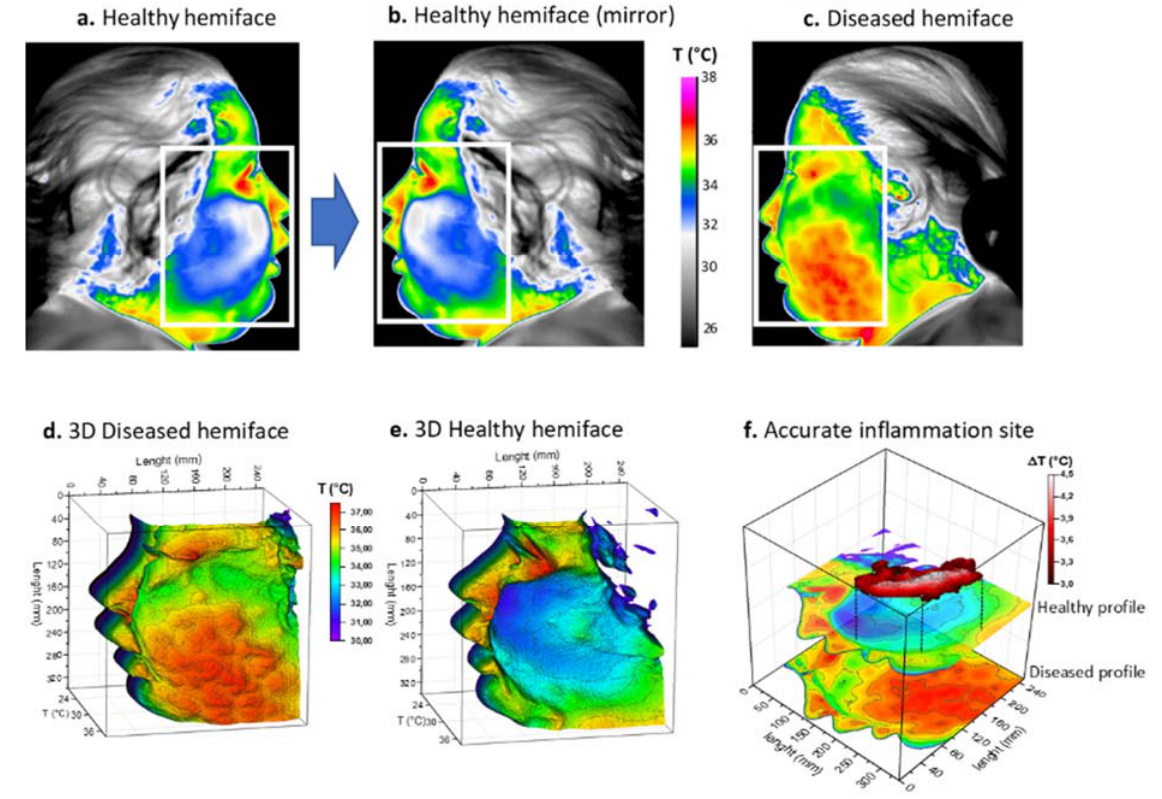
Figure 2. Thermal procedure of patient 1 with facial cellulitis. ( a ) Thermal image of the healthy hemiface with corresponding region of interest (ROI); ( b ) Returned (mirror) thermal image of the healthy hemiface; ( c ) Thermal image of the diseased hemiface with the same ROI; ( d , e ) 3D representations of the ROI weighted by temperature; ( f ) Image subtraction principle and resulting site of highest inflammation. White boxes correspond to the ROI.